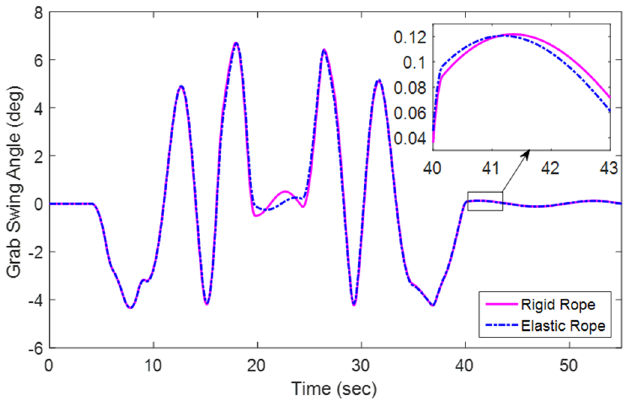
Fig. 8. Grab ’ s swing angle curves in the case of a rigid wire rope and an elastic wire rope.